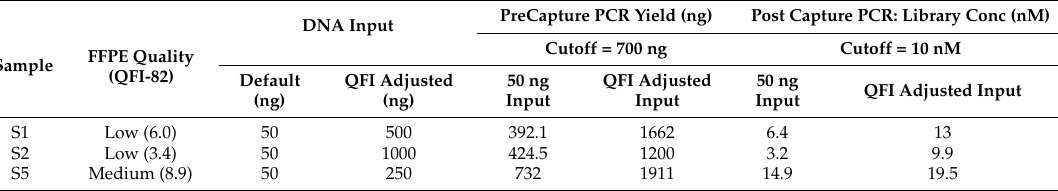
Table 1. Whole exome sequencing (WES) library prep pre-capture and post-capture quality control (QC) data on samples with default 50 ng input and amplifiability adjusted input. Successful pre-capture QC cutoff = 700 ng and post-capture cutoff = 10 nM. The Agilent SureSelect Clinical Research Exome was used in this